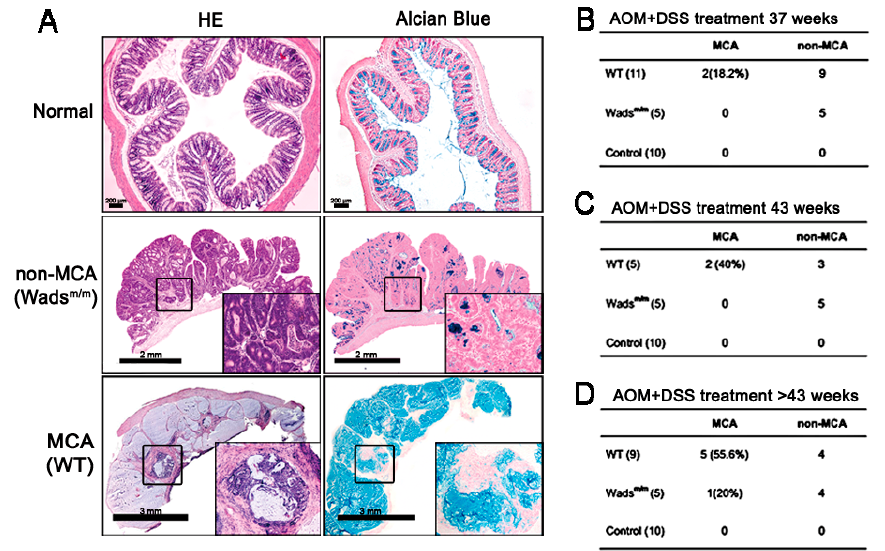
Figure 1. Establishment of the mucinous colorectal adenocarcinoma (MCA) murine model. ( A ) Azoxymethane (AOM) and dextran sodium sulfate (DSS) treatment for >37 weeks successfully induced colorectal cancer (CRC) in both WT and Wads m/m mice. Hematoxylin-eosin ( HE) staining showed the typical pathological characteristics of CRC including “back to back” dysplastic glands and abnormal nuclear divisions in all tumors. Additionally, some CRC tissues from WT mice exhibited the MCA subtype, as indicated by massive Alcian Blue-positive mucus. High magnification views are in the insets of each frame. Normal saline administered mice were set as normal controls. ( B – D ) The incidence of MCA in WT and Wads m/m mice at the indicated sacrifice time.